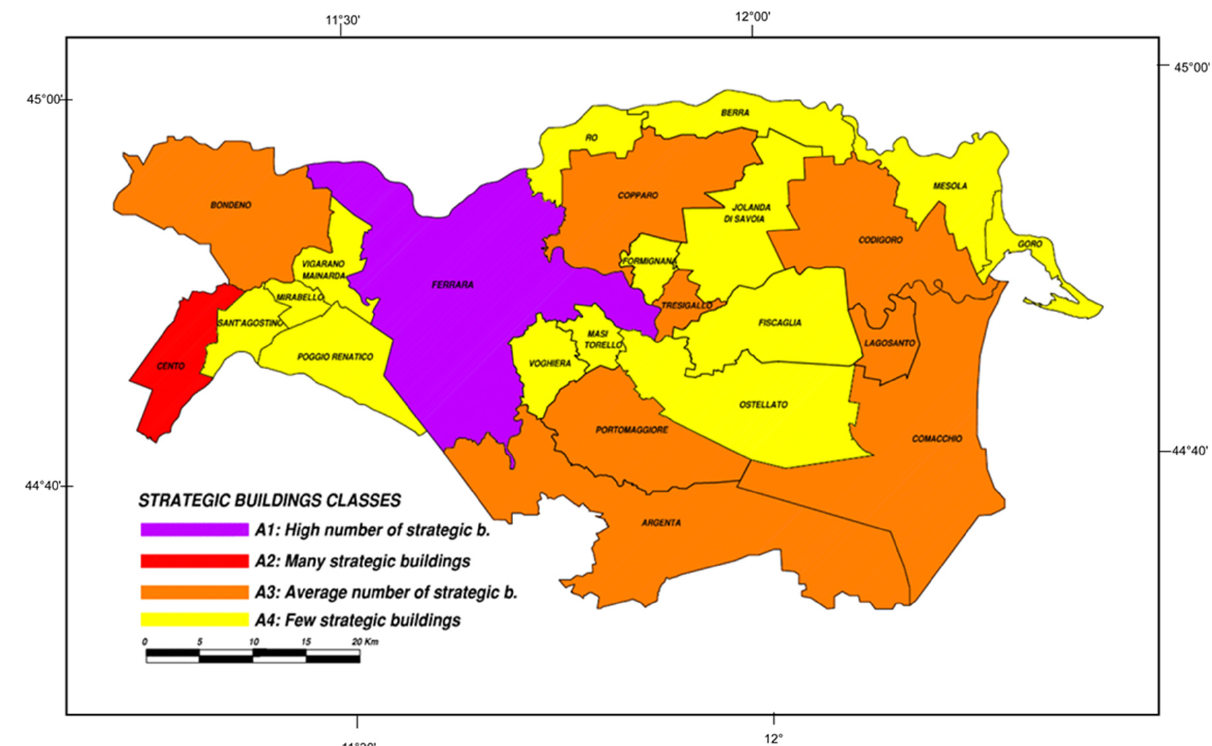
Figure 6. Map of strategic buildings incidence for the province of Ferrara.